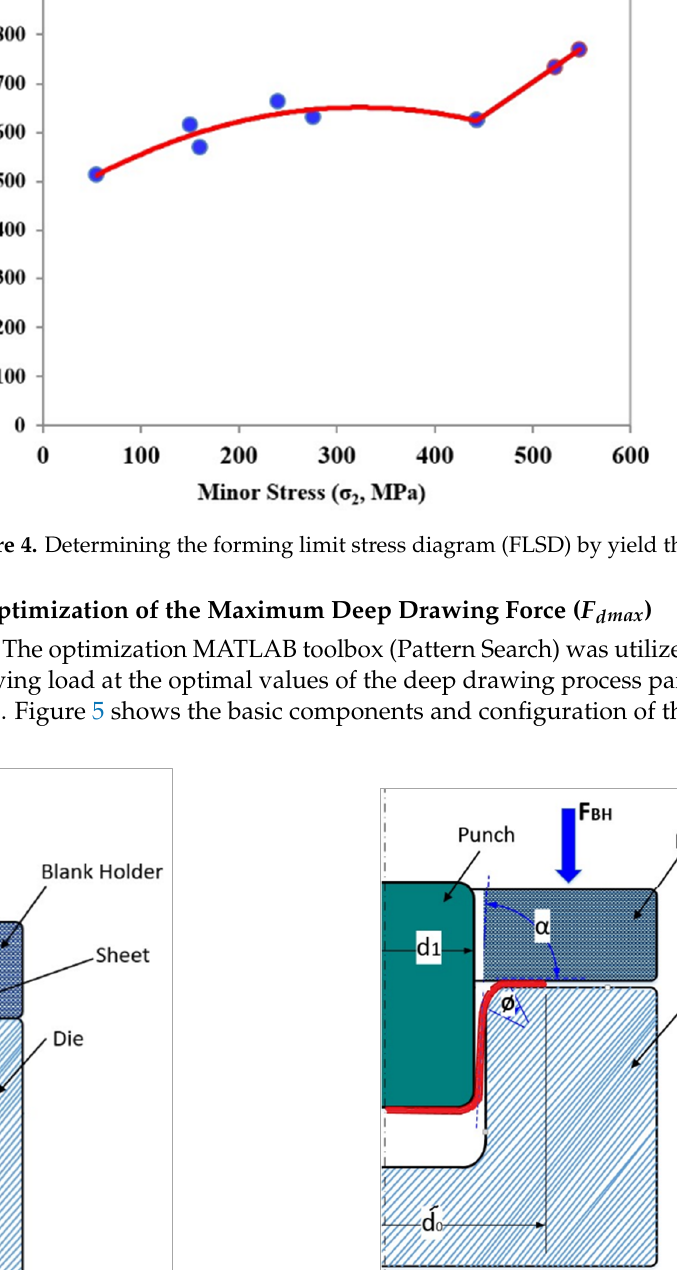
where σ 1 is a major stress, σ 2 is a minor stress, and σ 0 is the yield stress in the rolling direc- tion ( σ o ) of the sheet metal. Figure 4 shows the forming limit stress diagram for the sheet metal with a thickness equal to 0.8 mm.